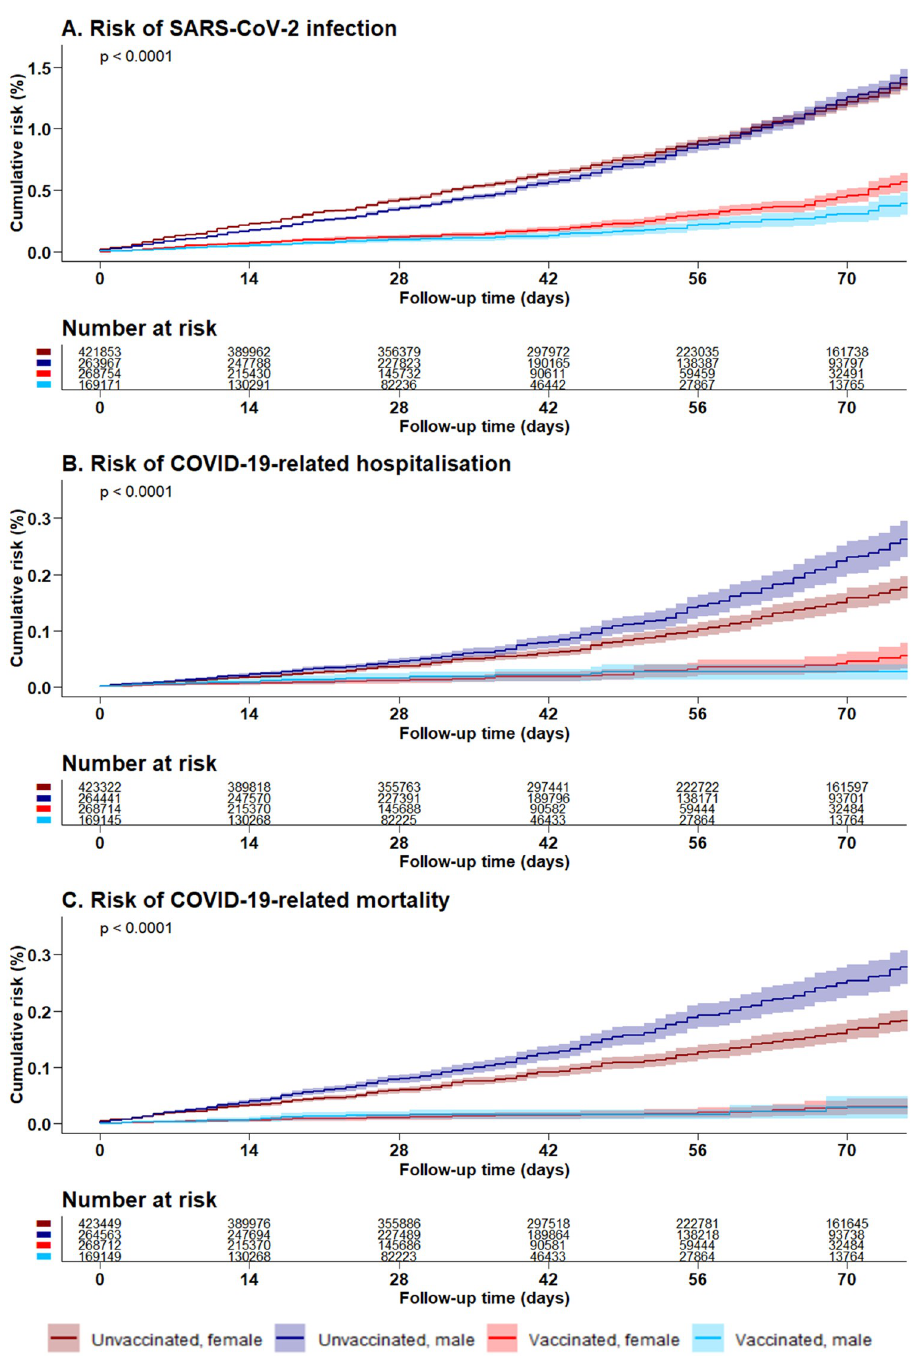
Fig 3. Risk of SARS-CoV-2 infection and related outcomes after two BNT162b2 vaccine doses in Bavarian persons aged 80 years and above. A. Risk of SARS-CoV-2 infection. B. Risk of COVID-19-related hospitalisation. C. Risk of COVID-19-related